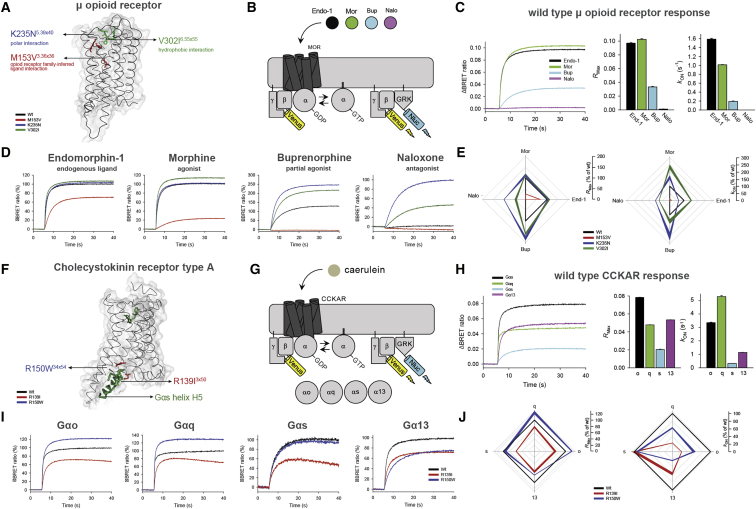
Effects of Natural Mutations on Drug Activity and G-Protein Coupling(A) Positions of selected missense variations of the μ-opioid receptor (MOR) near the ligand-binding pocket.(B) Schema of the BRET assay for real-time monitoring of G-protein activation. Activating μ-opioid receptors by agonist leads to the dissociation of inactive heterotrimeric G proteins into active GTP-bound Gα and Venus-Gβγ subunits. The free Venus-Gβγ then interacts with the Gβγ effector mimetic masGRK3ct-Nluc to increase the BRET signal.(C) Ligand/drug-induced maximum BRET amplitude (RMax) and activation rate constants (kON) by wild-type μ-opioid receptor (mean ± SEM, n = 6 wells).(D) Real-time monitoring of ligand/drug actions on μ-opioid receptor mutants (mean response trace, n = 3 or 6).(E) Quantification of stimulus bias (RMAX, left and kON, right) of μ-opioid receptor mutants. The values of agonist-induced responses were normalized to the reference, wild-type μ-opioid receptor (black line). The values of naloxone-induced responses were normalized to the K235N3.36x36 mutant (thickness represents the SEM over n = 3).(F) Positions of selected missense variations of the Cholecystokinin receptor type A.(G) Schema of the BRET assay for real-time monitoring of G-protein activity for CCKAR experiments.(H) Agonist-induced maximum BRET amplitude (RMax) and activation rate constants (kON) by wild-type CCKAR (mean ± SEM, n = 6 wells).(I) Real-time monitoring of G-protein activation by CCKAR mutants stimulated with caerulein (30 μM, applied at 5 s, n = 3) normalized to the maximum amplitude of the wild-type receptor.(J) Quantification of G-protein-coupling bias (RMAX, left and kON, right) of CCKAR mutants normalized to wild-type CCKAR (black line, thickness represents the SEM over n = 3).See also Figure S5.